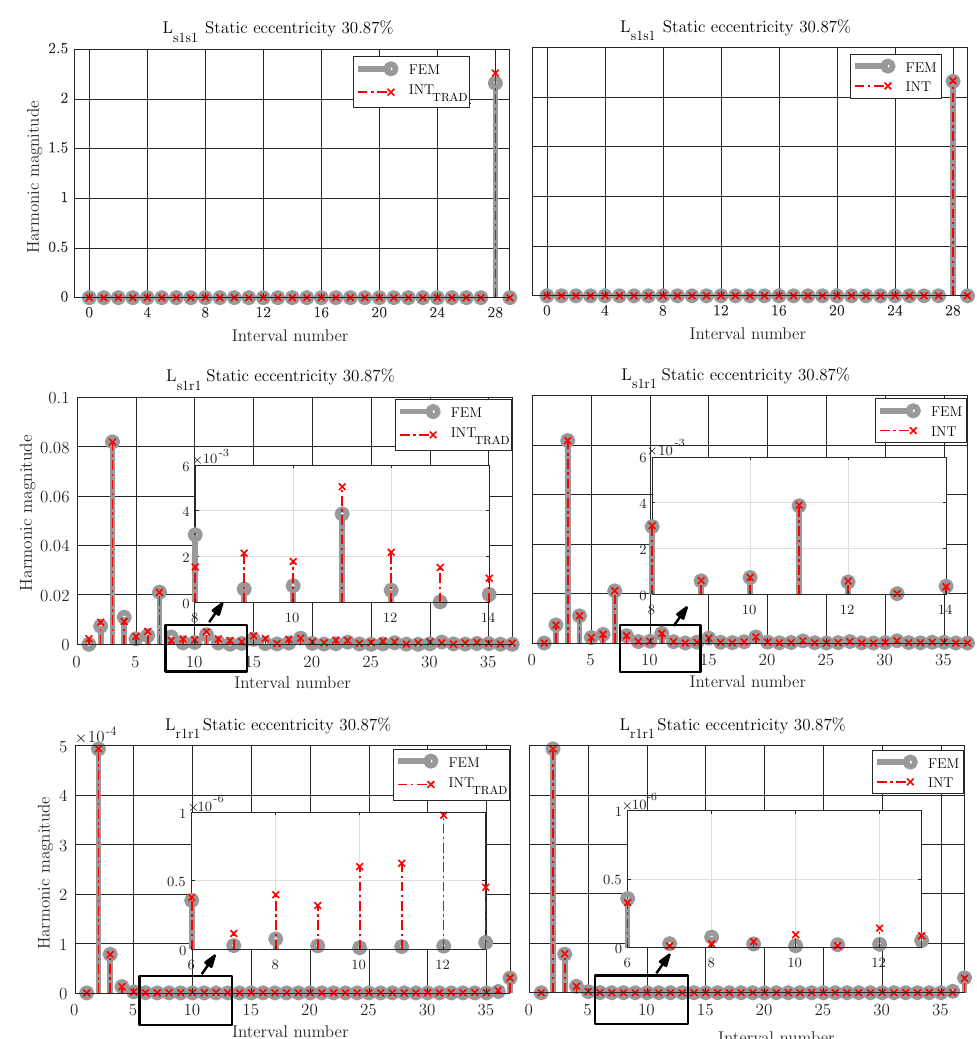
Figure 10. Space harmonics content of the coupling parameters between stator phase 1 and itself ( top ), between stator phase 1 and rotor bar 1 ( middle ) and between stator phase 1 itself ( bottom ), in the case of 30.87% of static eccentricity using FEM simulations and traditional trigonometric interpolation polynomial ( left ) and using FEM and trigonometric interpolation considering space harmonics (right). The traditional trigonometric interpolation obtains values of space harmonics other than FEM while both the order and the amplitude of the space harmonics contents using the proposed method are the same as using FEM with a very small